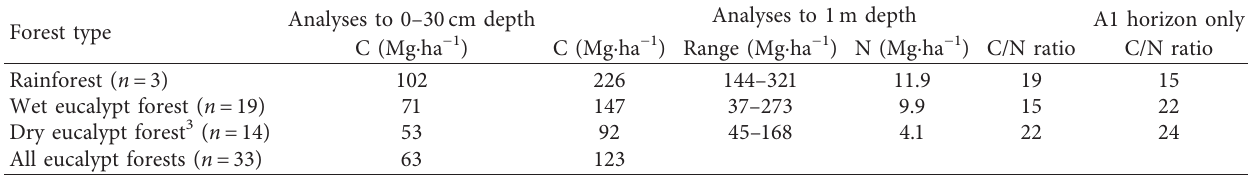
Table 1: Mean carbon and nitrogen to 1m depth for three Tasmanian forest types 1,2 .